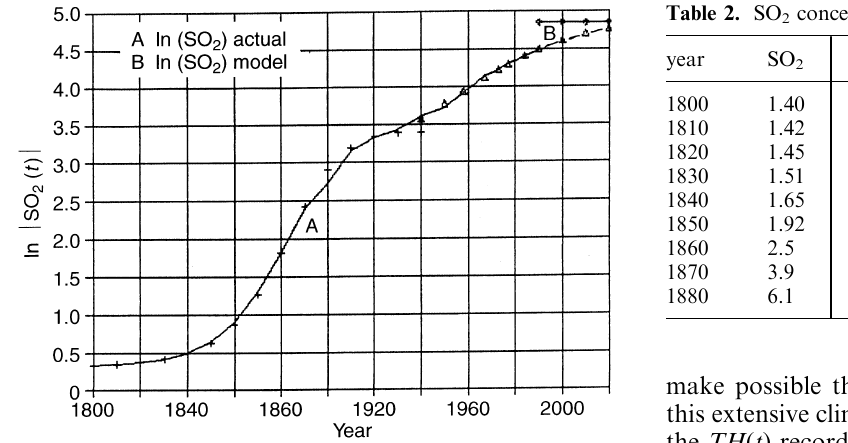
Fig. 6. Atmospheric SO